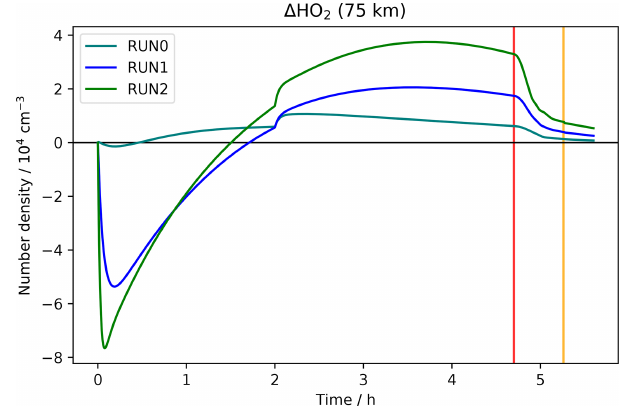
Figure 12. Modelled change of HO 2 at 75km altitude for the three model simulations RUN0, RUN1, and RUN2. Shown are differ- ences between the sprite model runs and the model simulation with- out electric fields applied. The vertical orange line indicates the time of sunrise, and the vertical red line indicates the time when the model starts to account for scattered sunlight (at a solar zenith angle of 98 ◦